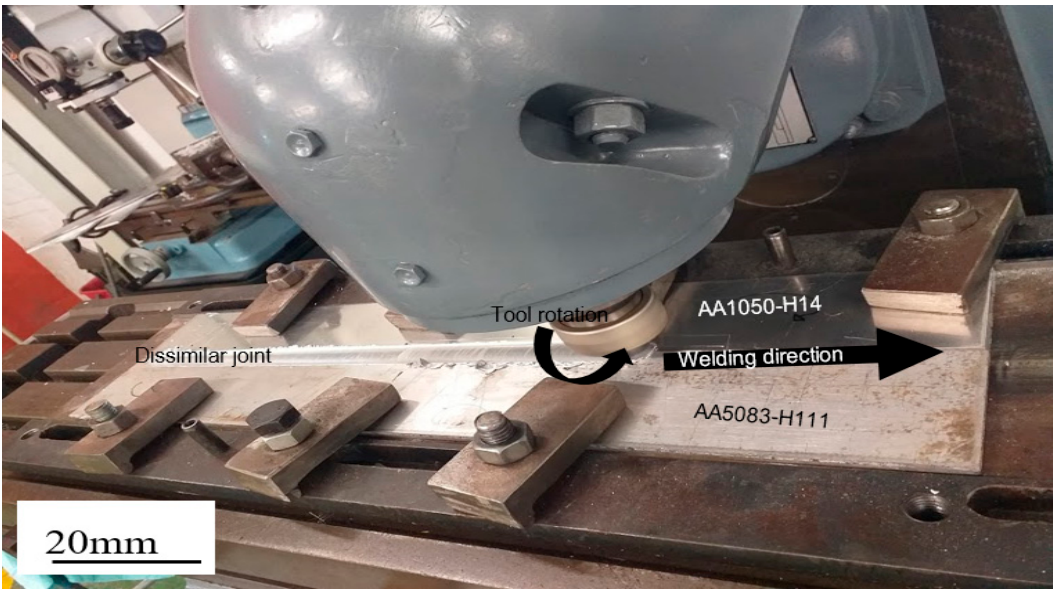
Figure 1. Aluminium alloy plates prepared for welding.